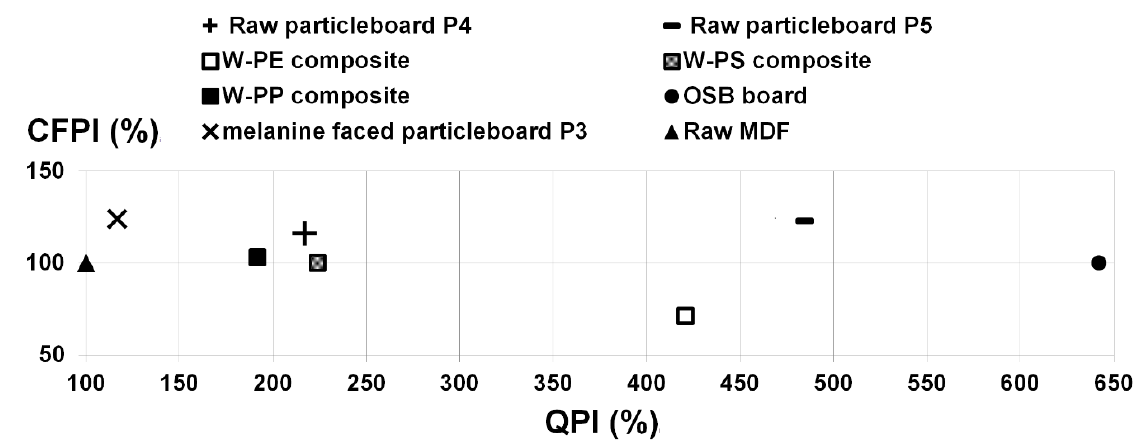
Figure 9. Differentiation of five standard wood-based boards and three innovative wood–plastic particleboard in terms of difficulty in drilling, determined by two independent indexes ( QPI and CFPI , which have been defined by mathematical Equations (2) and (3) in Section 3).